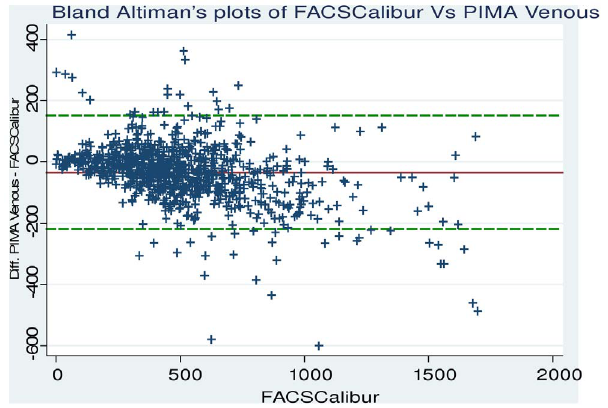
Figure 2. Bland-Altman plots comparing FACSCalibur and PIMA venous measurements.